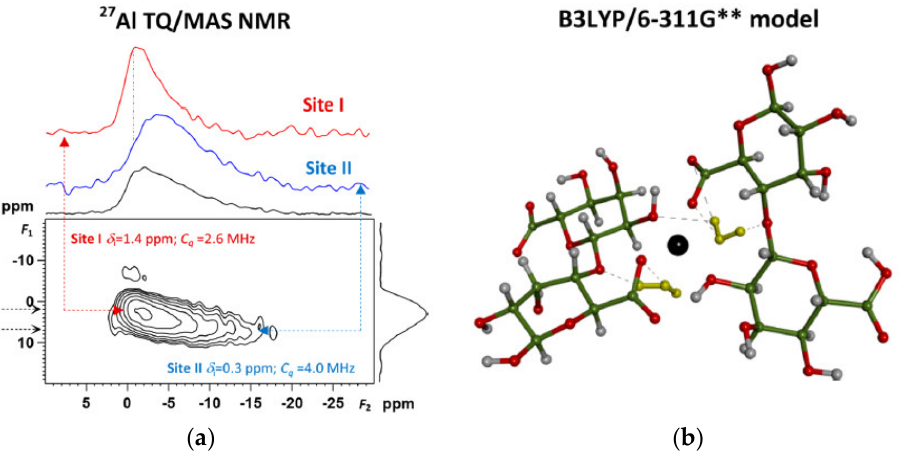
Figure 11. ( a ) 2D 27 Al TQ/MAS NMR spectrum of Al-alginate; ( b ) computational model of Al-alginate—the octahedral arrangement (yellow lines) of the ligands surrounding Al 3+ (the black circle).